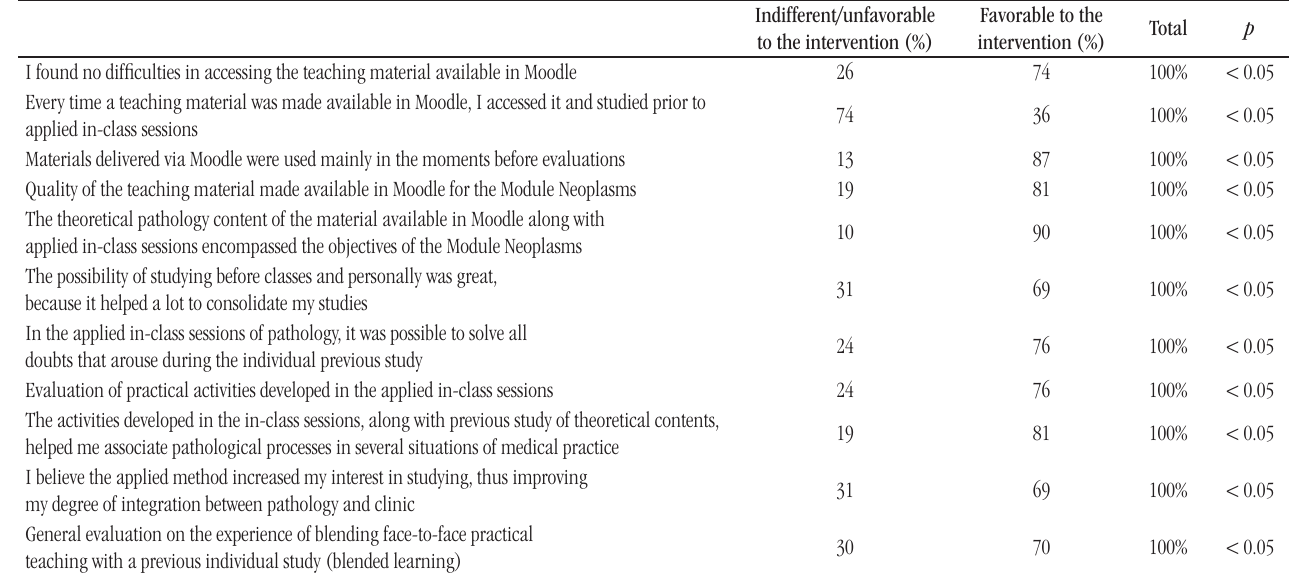
taBLE − Results in percentage favorable or not favorable/indifferent to the intervention